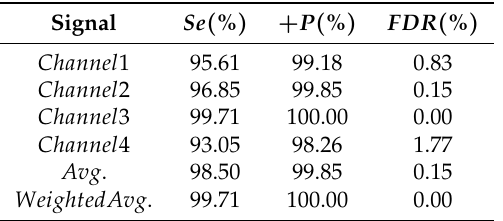
Table 2. Comparisons of the results of sensitivity, positive predictivity, and failed detection rate for the mixed signal for both the average method ( Avg .), weighted average method ( WeightedAvg .), and each channel under the rest environment. Signal Se ( % ) + P ( % ) FDR ( %